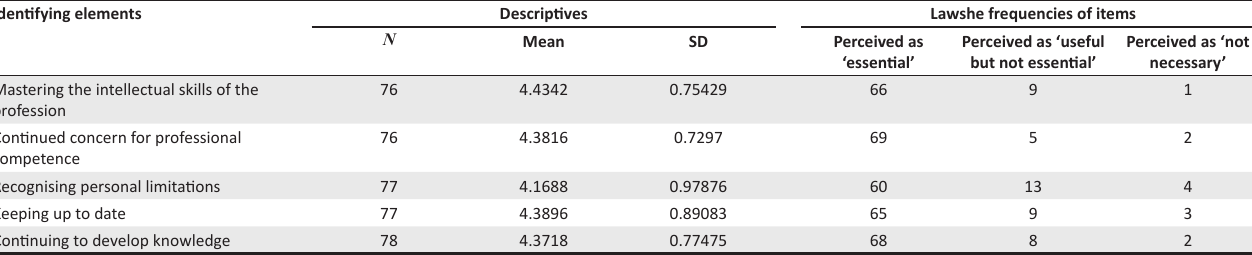
TABLE 15: Descriptive statistics of responsibility for knowledge and skills. Identifying elements